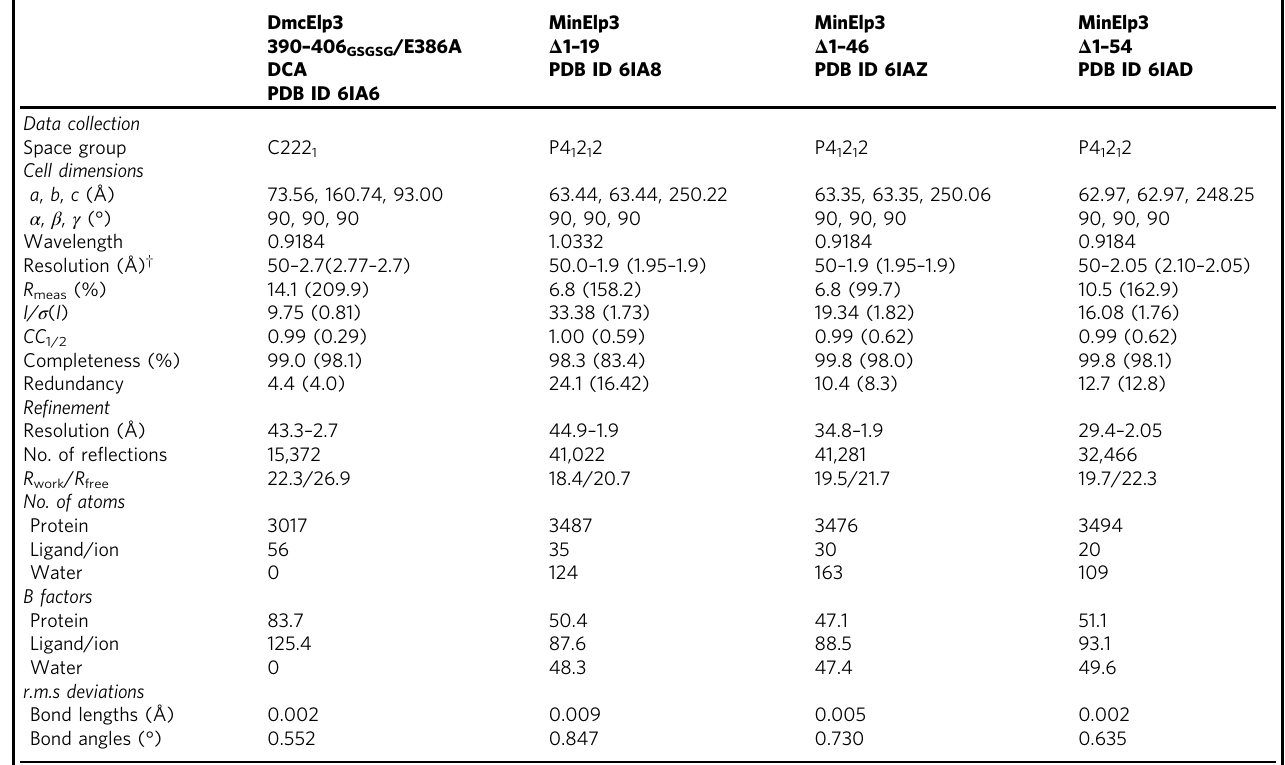
Table 1 Data collection, phasing and re fi nement